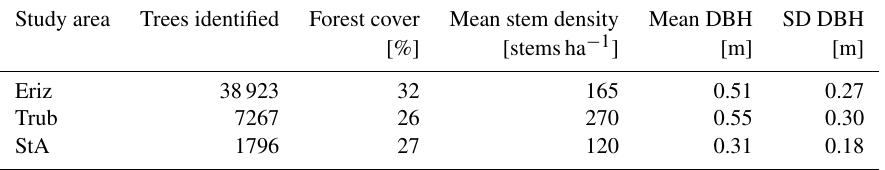
Table 3. Vegetation parameters in the study areas. Source of forest cover: Federal Office of Topography swisstopo (Swisstopo, 2020). Source of hillshade: Federal Office of Topography swisstopo (Swisstopo, 2018).